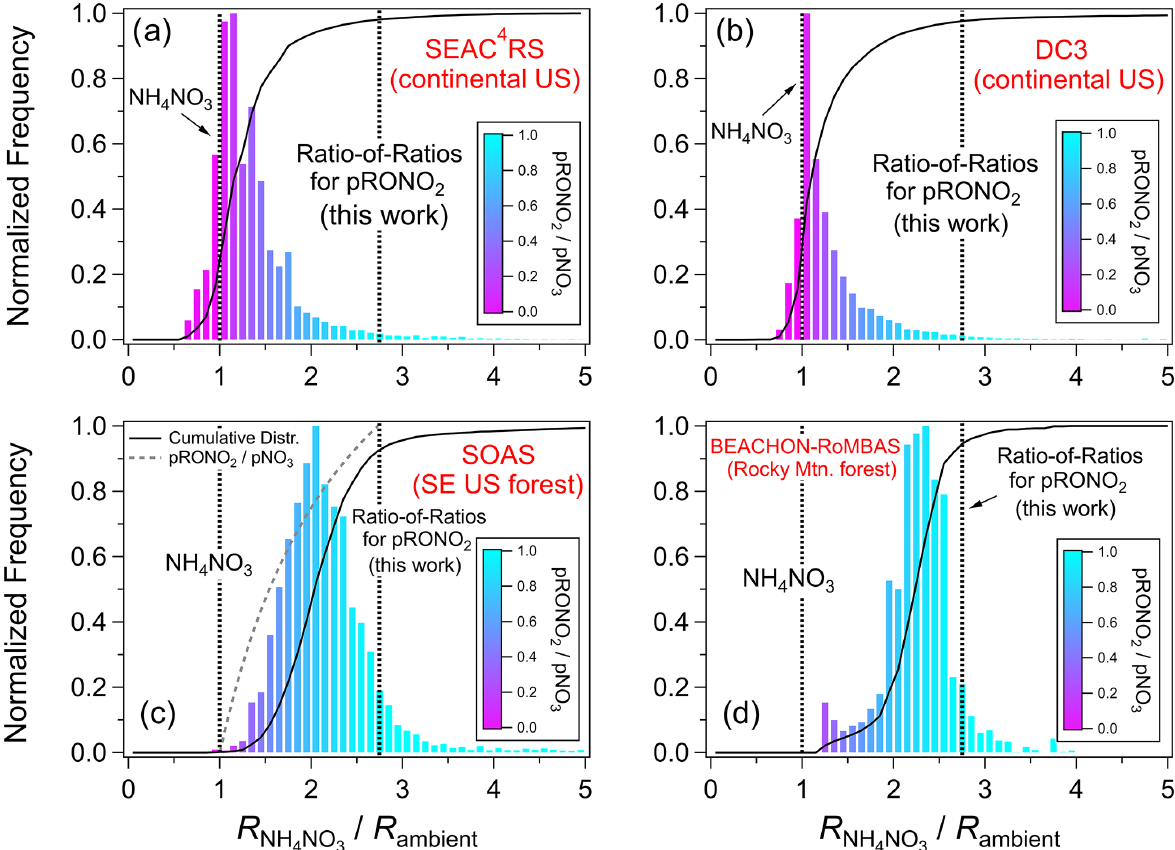
Figure 2. Histograms of ambient NO + x ratios for aircraft and ground-based campaigns. The data are shown as the calibration R NH divided by R ambient , so that all data are on the same reference coordinates. The histograms are weighted by pNO 3 concentration. Cumula- tive distributions are shown in all plots, and an additional curve only in the SOAS panel shows the f pRONO coordinates (would be identical in all panels). The data used were 1min averages and screened for pNO 3 detection limits for the aircraft campaigns (SEAC 4 RS, DC3) and 1h averages for the ground-based campaign (SOAS, BEACHON-RoMBAS). Measured R NH for these studies were as follows: SEAC 4 RS (range 0.40–1.49, mean and SD 0.80 ± 0.31), DC3 (0.71 ± 0.04), SOAS (0.44 ± 0.02), and BEACHON-RoMBAS (0.295 ± 0.005). See Fig. S6 for equivalent plots where distributions are not weighted by mass